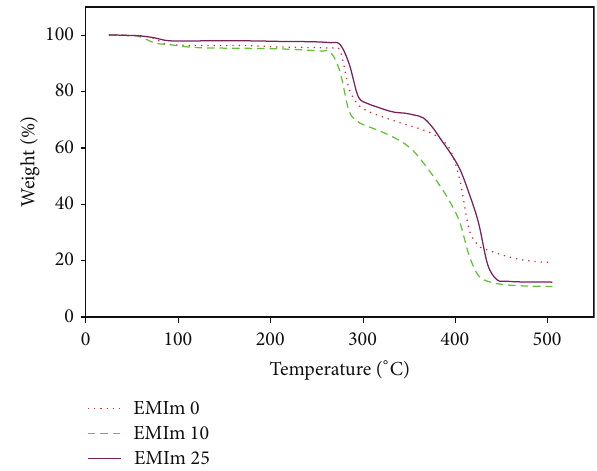
Figure 4: Thermogravimetric curves of EMIm 0, EMIm 10, and EMIm